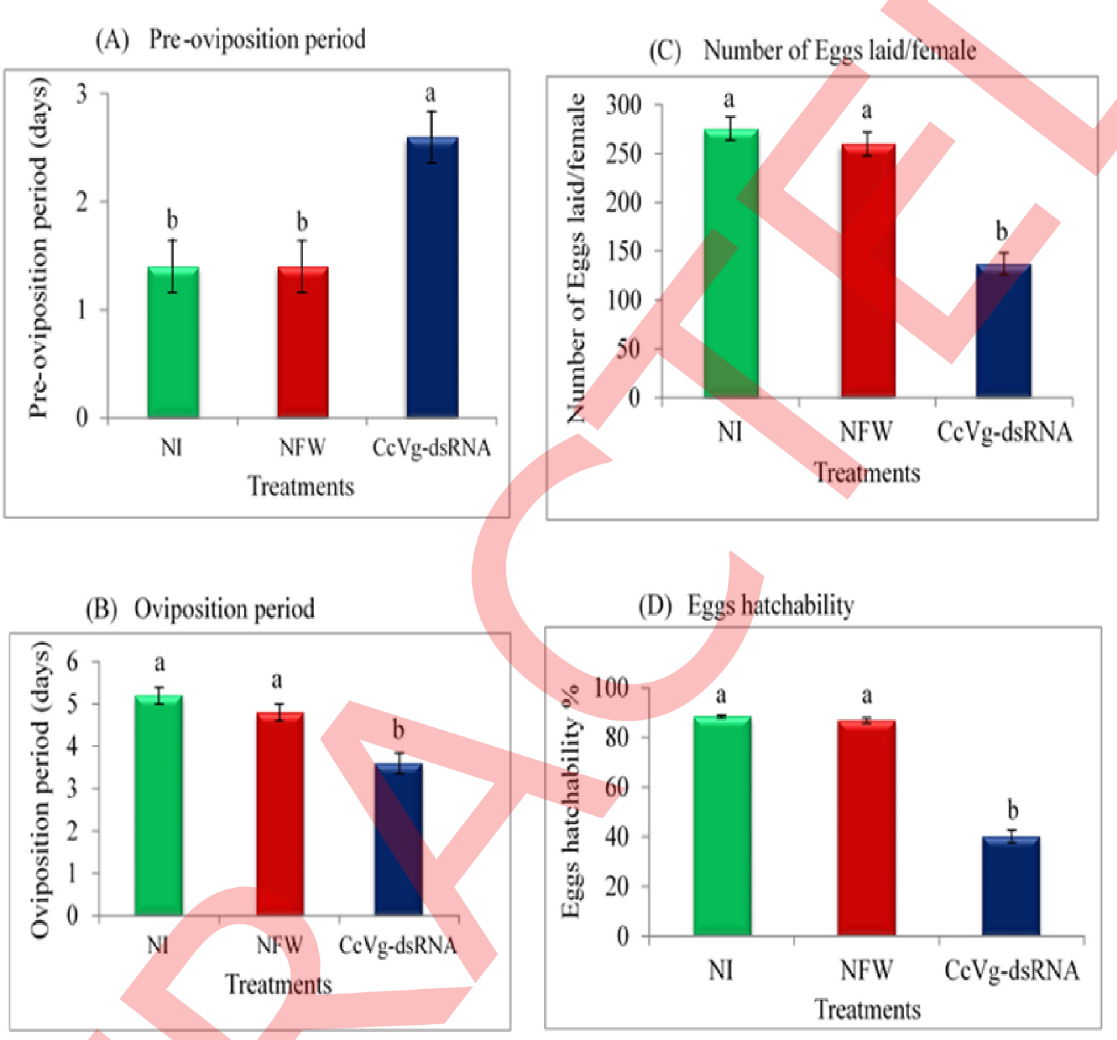
Fig 8. Effects of the CcVg gene knockdown on Cadra cautella females reproductive traits. (A–B): Pre-oviposition and oviposition periods (C–D): mean number of eggs laid per female and egg hatchability.